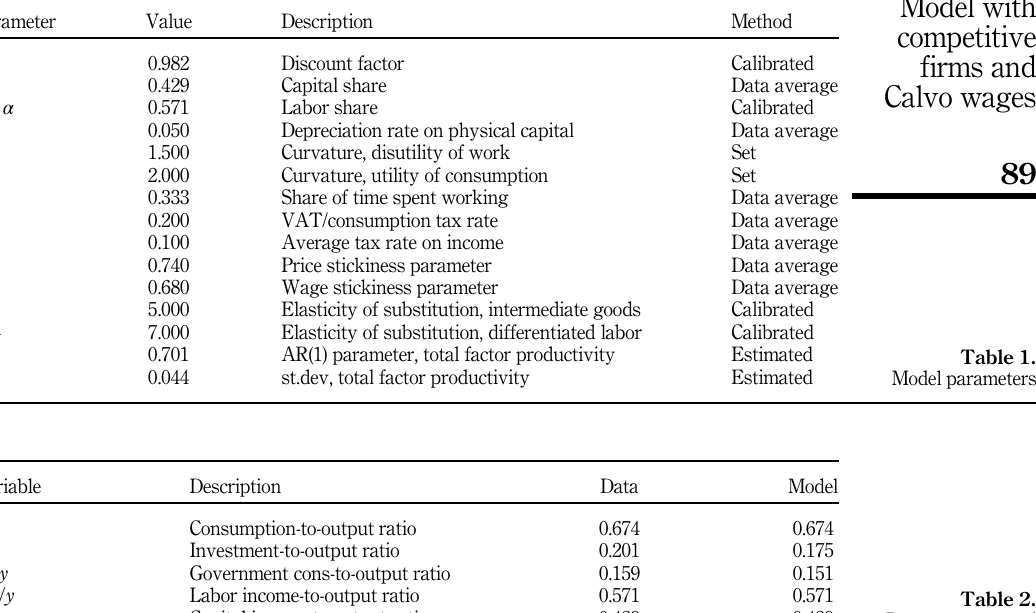
Table 2. Data averages